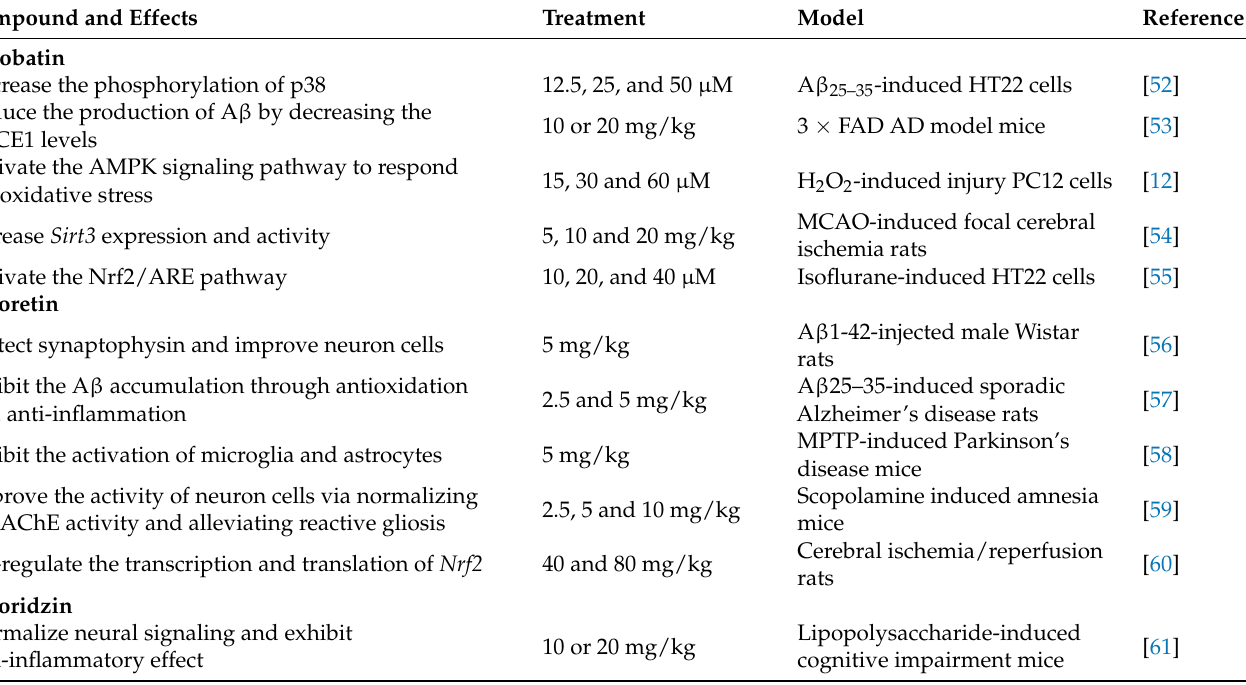
Table 2. Neuroprotective effects of the